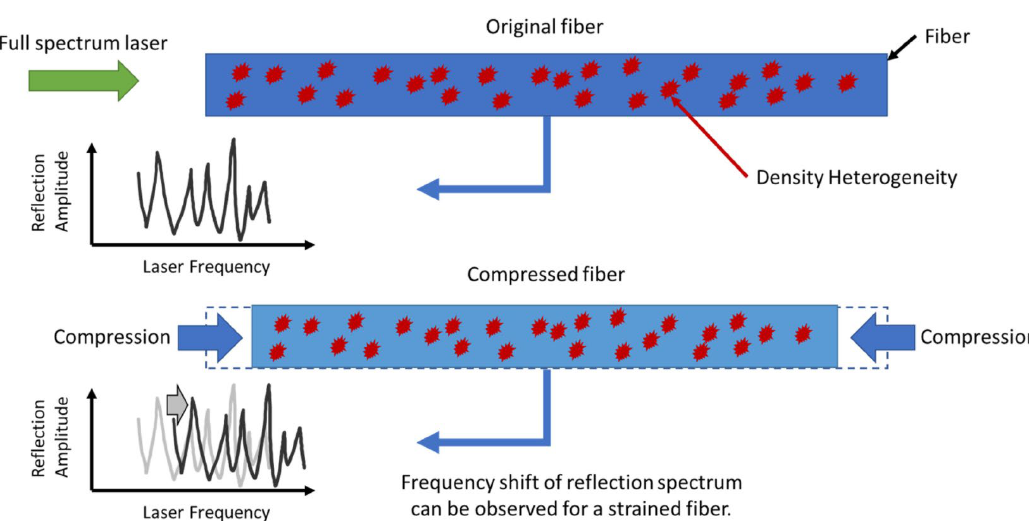
Figure 3. The principle of DSS measurement [16].